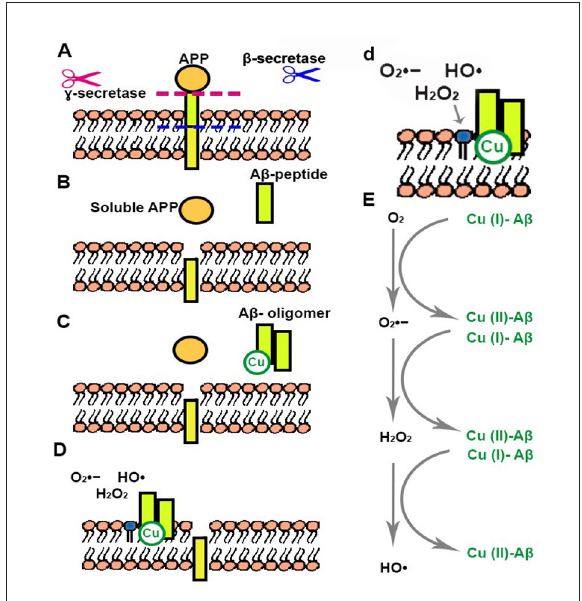
FIGURE1 Generation of A β peptides and Cu related ROS production. (A) A β peptide is produced from the proteolysis of APP that takes place through the action of β - and γ -secretases. (B) A β peptide and soluble APP are released. (C) A β peptide forms oligomers that can interact with Cu. (D,d) A β oligomer-Cu complexes are incorporated into the cellular membrane generating changes in nearby phospholipids. (E) A β oligomer-Cu complexes can be oxidized in the presence of O 2 , generating different